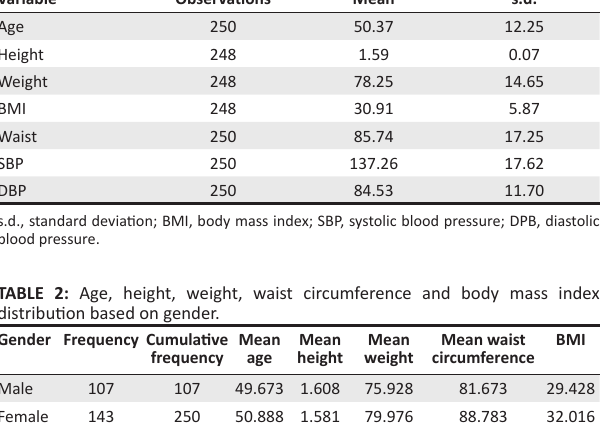
TABLE 1: Physical characteristics. Variable